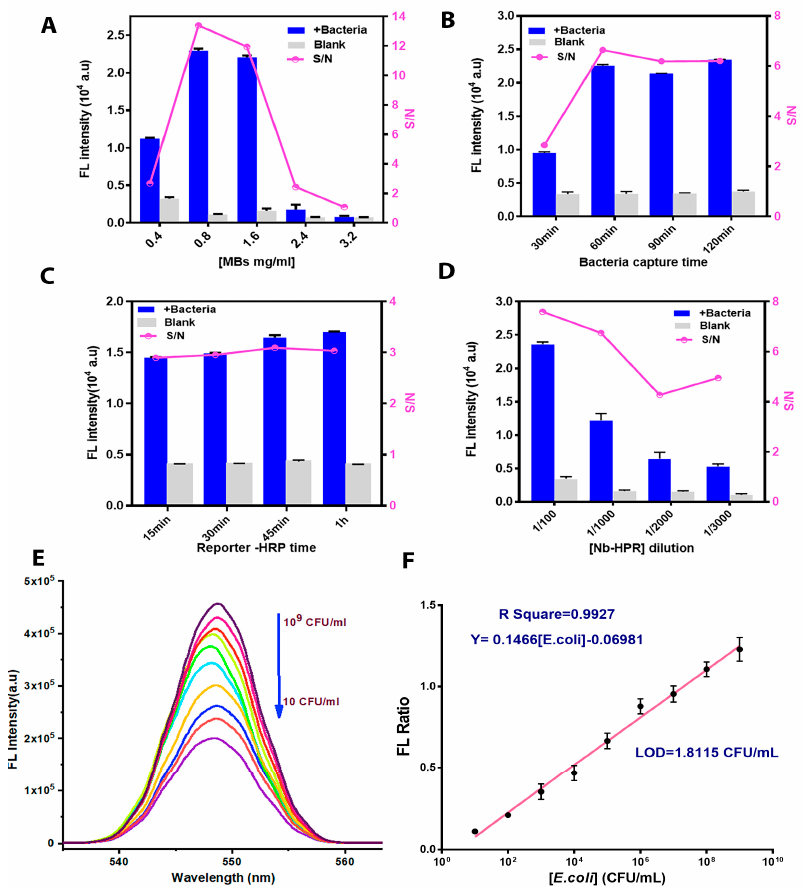
Figure 2. Optimization of the influential parameters of the bioassay. ( A ) Optimization of the MB concentration. ( B ) E. coli F17 capture time. ( C , D ) Dilution factor of the HRP-conjugated nanobody and its hybridization time. Error bars estimated as three times the standard deviation ( n = 3). Blue bars (+bacteria): E. coli F17 (1 × 10 6 CFU/mL), grey bars (-bacteria): only PBS solution, S/N: signal-to-noise ratio. ( E ) Fluorescence emission spectra ( λ ex / λ em : 450/550 nm) obtained from various concentrations of F17-positive E. coli ; ( F ) the corresponding calibration plots. The standard deviations of measurements were calculated from three independent replicates.